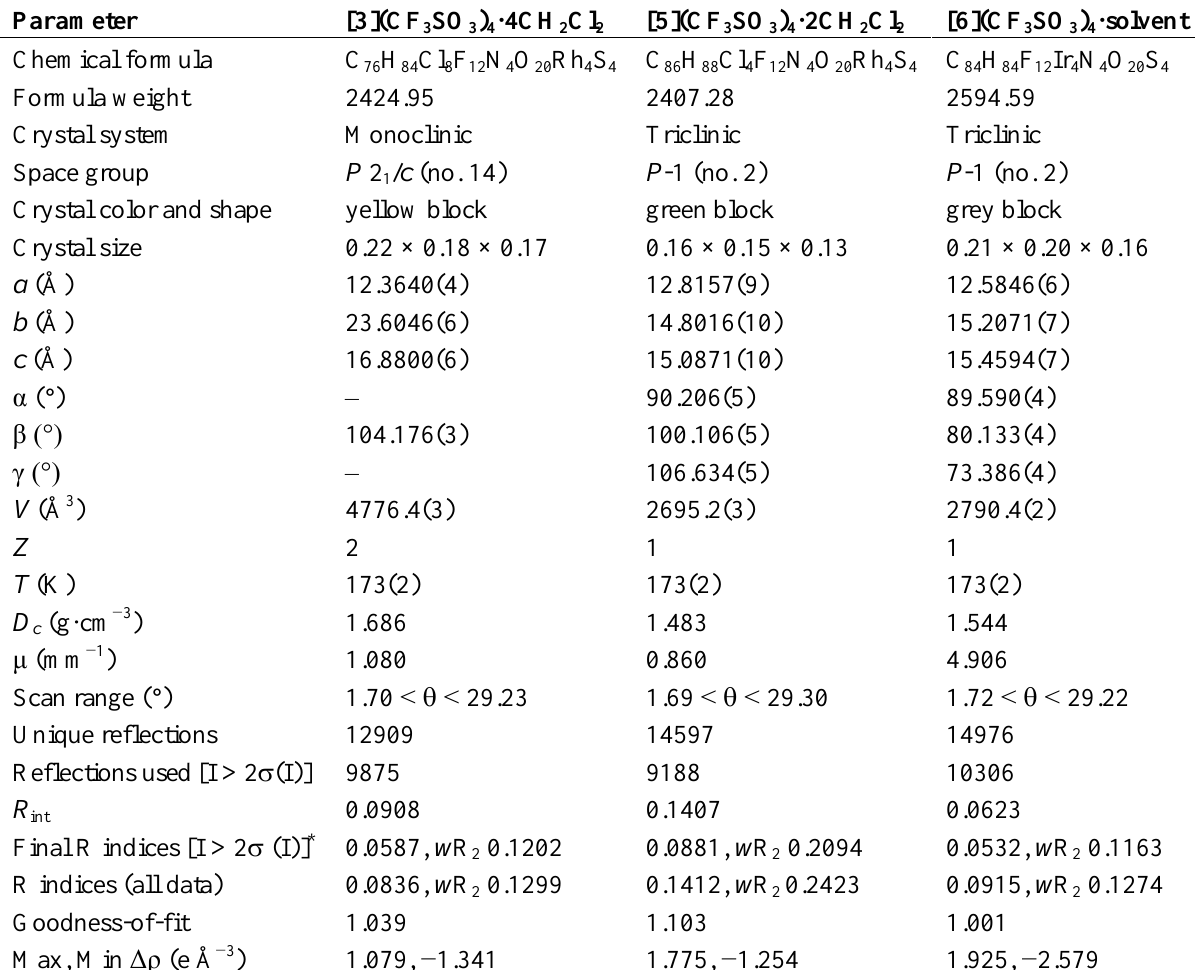
Table 2. Crystallographic and structure refinement parameters for